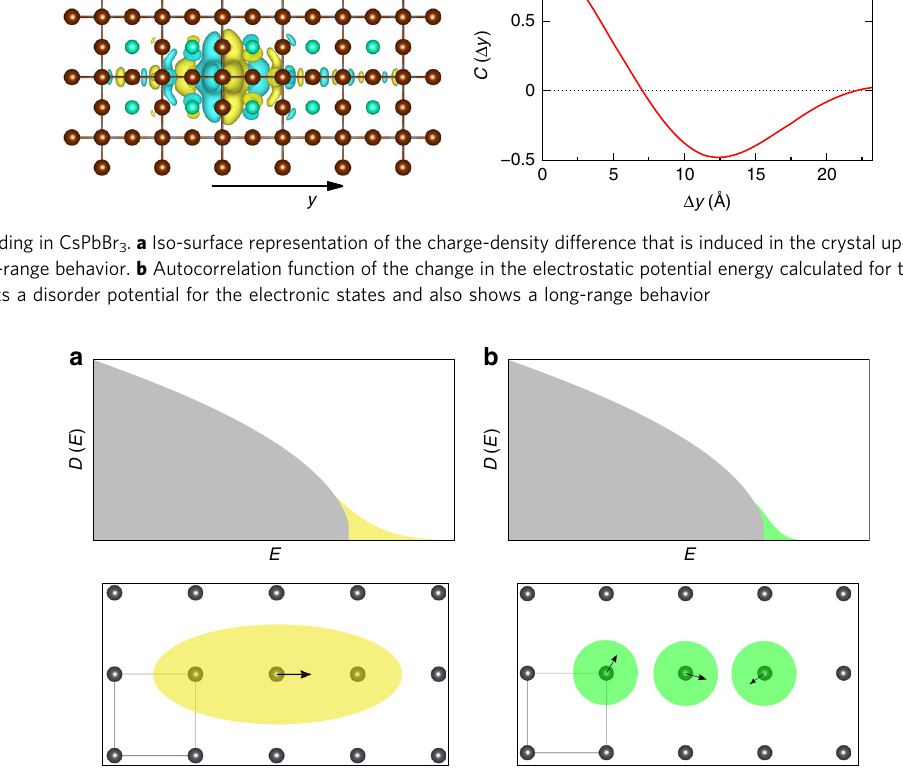
shows data for C Δ y ð Þ corresponding to three cases: (i) con fi g- urations of Pb atoms chosen from the MD trajectory, but Cs and Br atoms being fi xed to their ideal lattice positions; (ii) con fi g- urations of Pb and Br atoms chosen from the MD trajectory, but only Cs atoms being fi xed to their ideal lattice positions; and (iii) con fi gurations of Pb and Cs atoms chosen from the MD trajec- tory, but only Br atoms being fi xed to their ideal lattice positions. It is found that Pb displacements induce a disorder potential for the electronic states showing a spatial correlation that sig- ni fi cantly exceeds atomic distances, in line with the expectation borne from the resonant bonding mechanism discussed above.